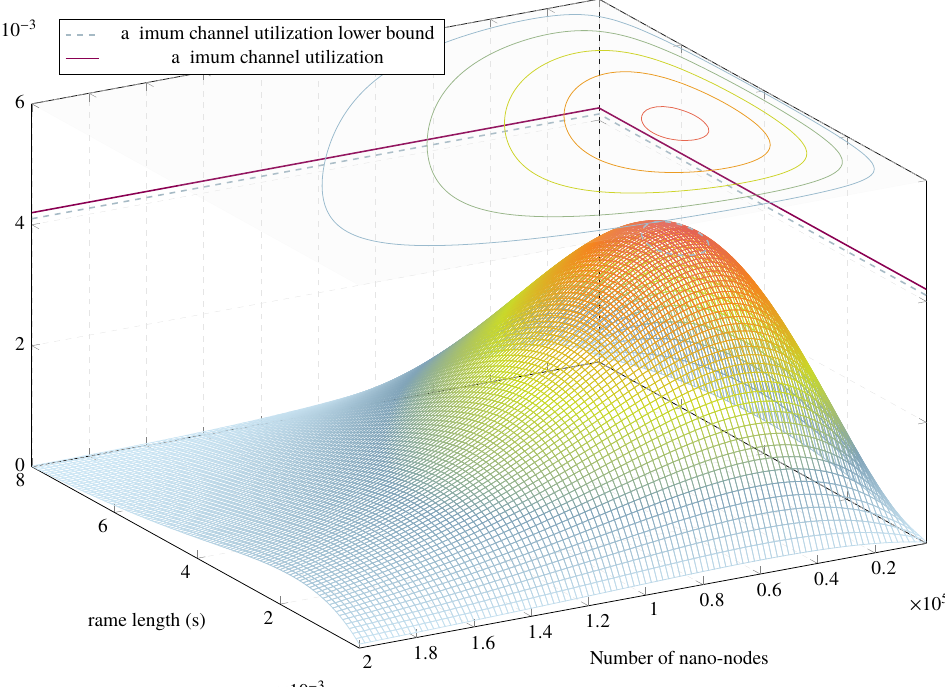
Figure 2. Channel utilization as a function of n and t f